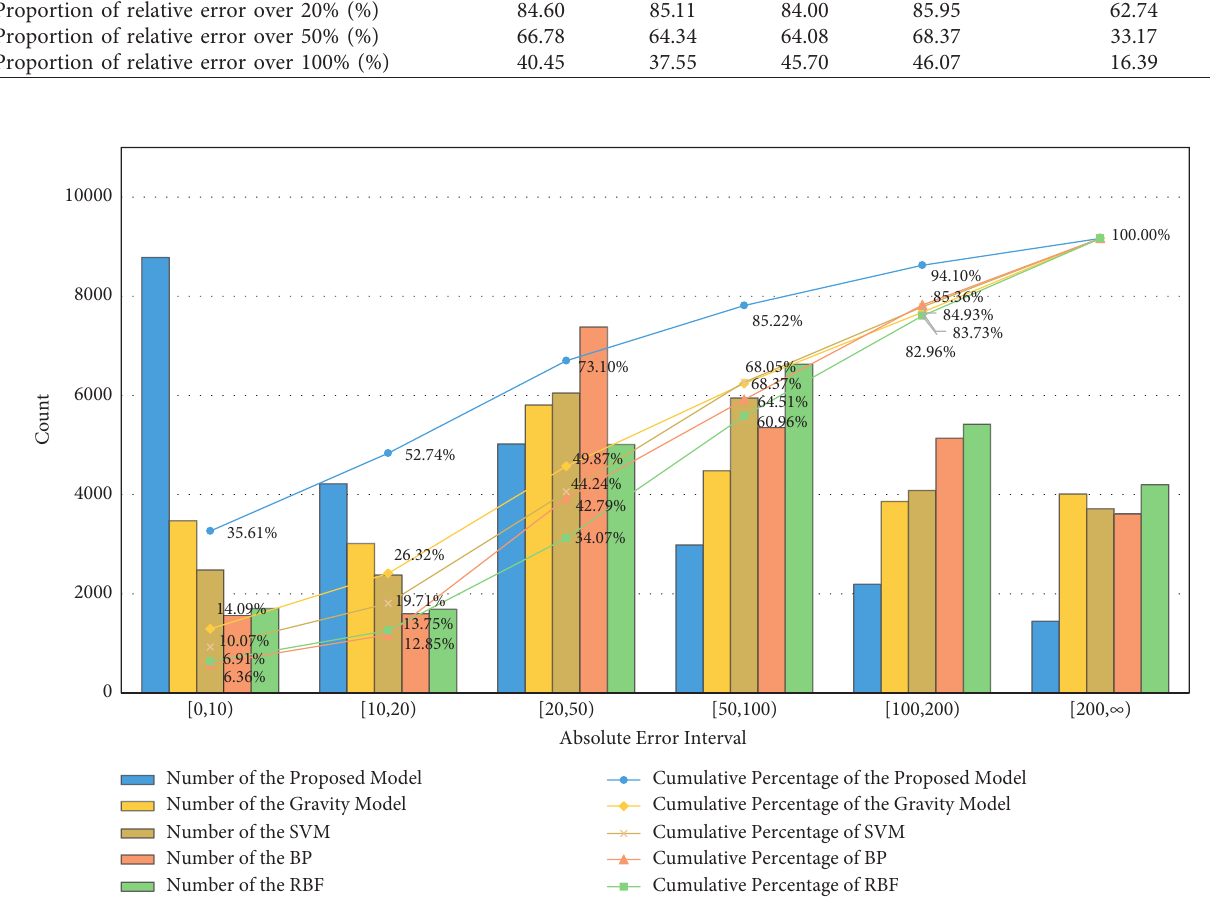
Figure 5: Comparison of absolute error and cumulative